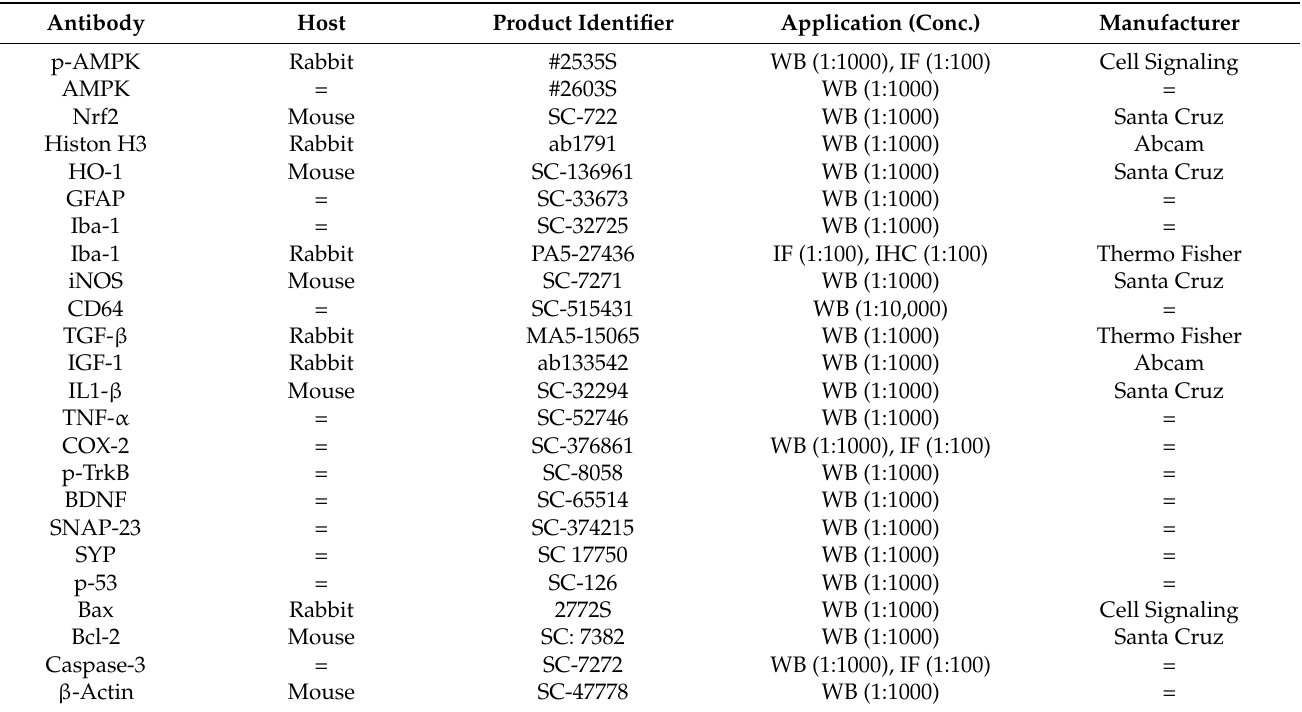
Table 1. List of primary antibodies used in immunoblotting and immunofluorescence